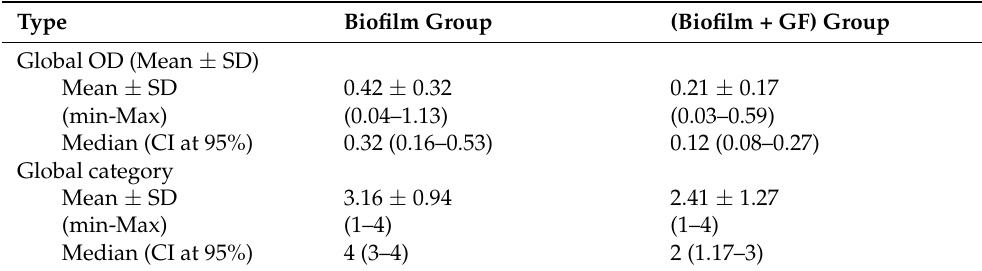
Table 3. Characteristics for biofilm and biofilm + GF groups of Global category and Global OD